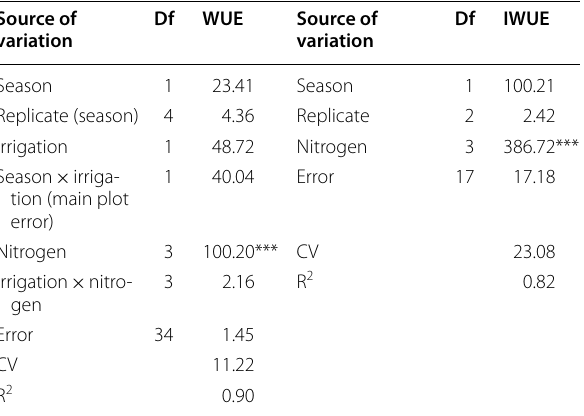
*** is a significance code at 0.001